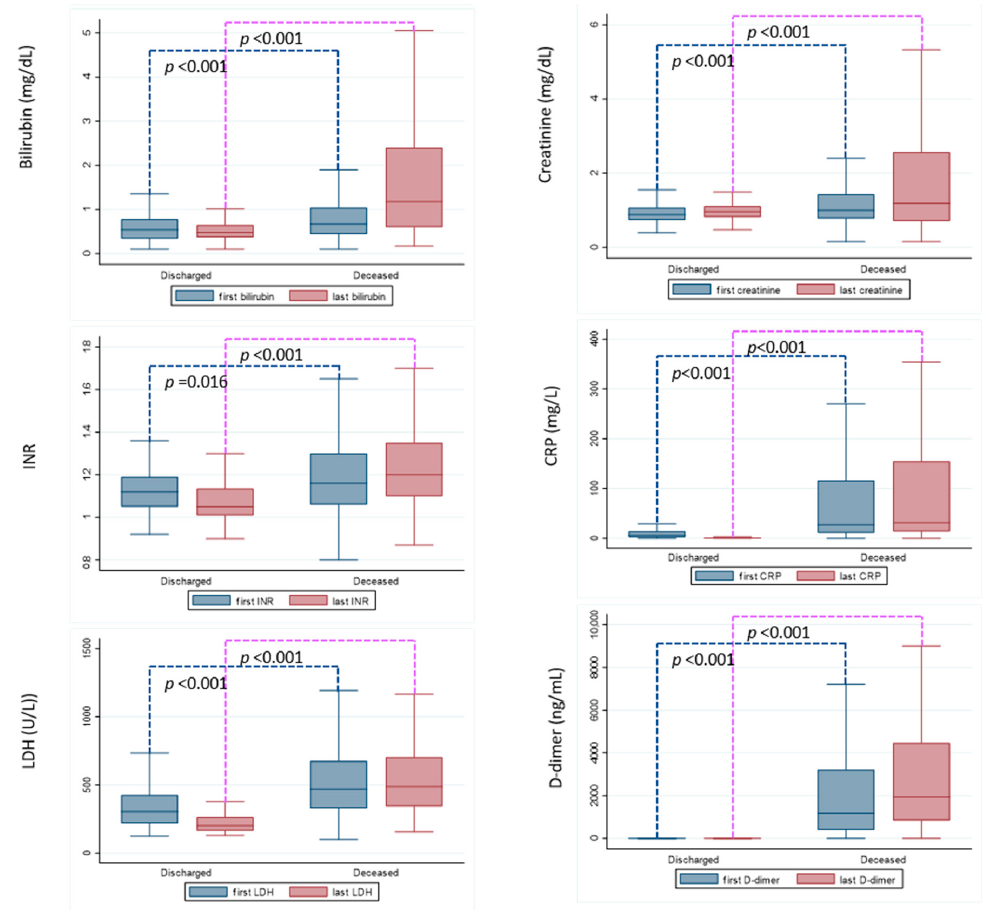
Figure 2. Laboratory parameters at hospital admission and before discharging in deceased vs. discharged patients. Outside values were excluded. The Mann–Whitney U test was used to assess differences between